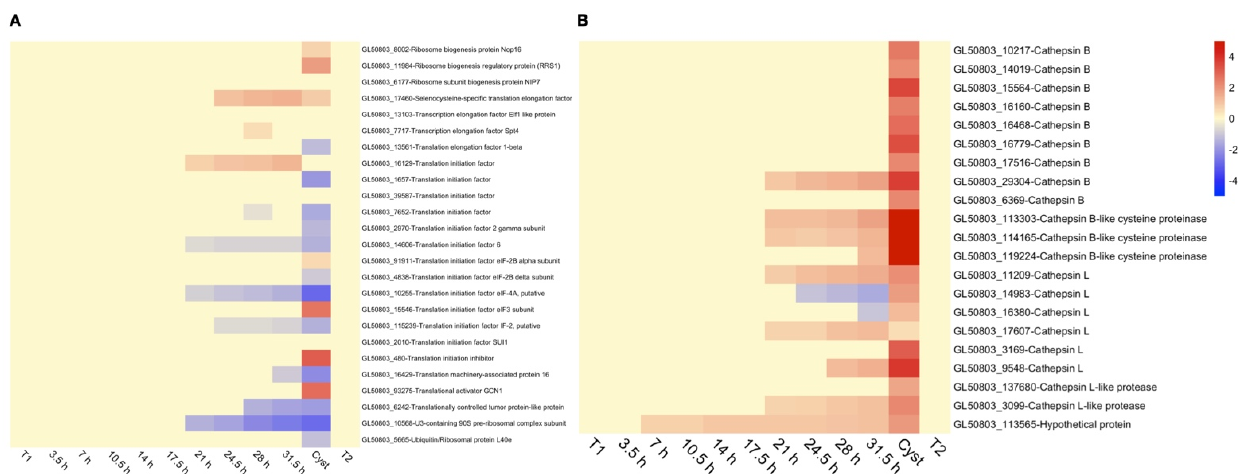
Figure 5. Heat-maps showing expression changes through-out encystation of ( A ) translation initiation factors and ( B ) cathepsins. Expression changes are in log2 space and capped at -5 and 5, respectively, to improve visualization. Up-regulation is shown in red, while down-regulation is shown in blue. For each gene, the unique Geneid (starting in GL50803_) and the annotated function is given.